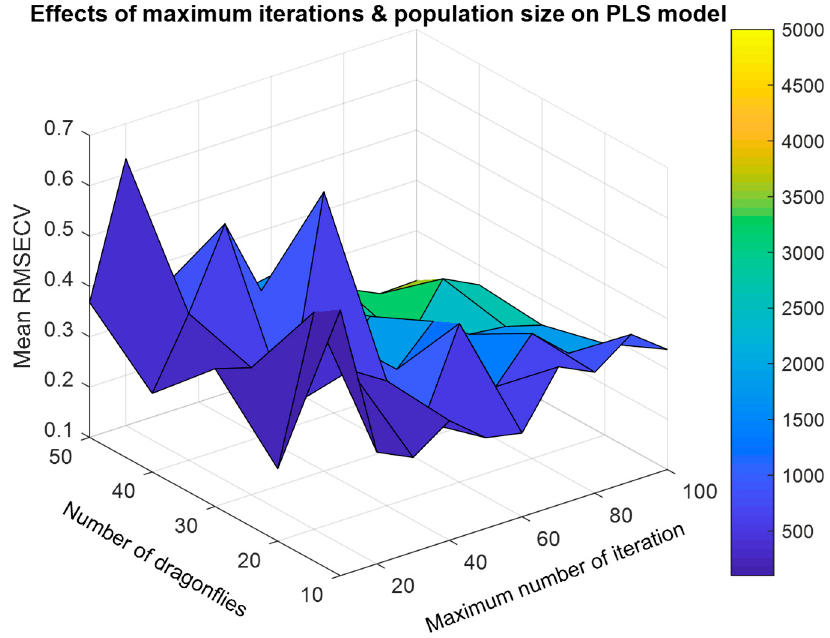
Figure 9. Influence of maximum number of iterations and number of dragonflies on the generalized performance of quantitative analysis model.